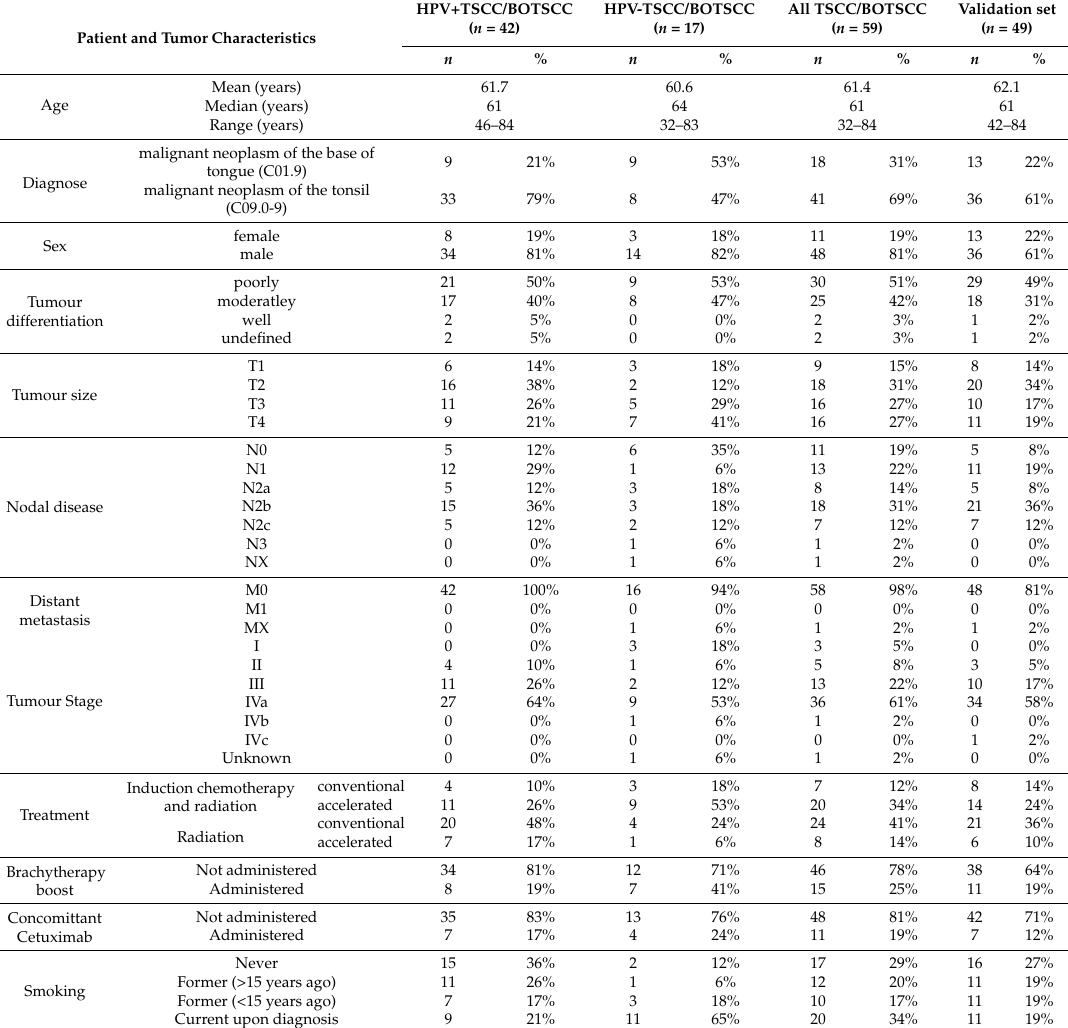
Table 1. Patient and tonsillar squamous cell carcinoma (TSCC)/base of tongue squamous cell carcinoma (BOTSCC) characteristics.